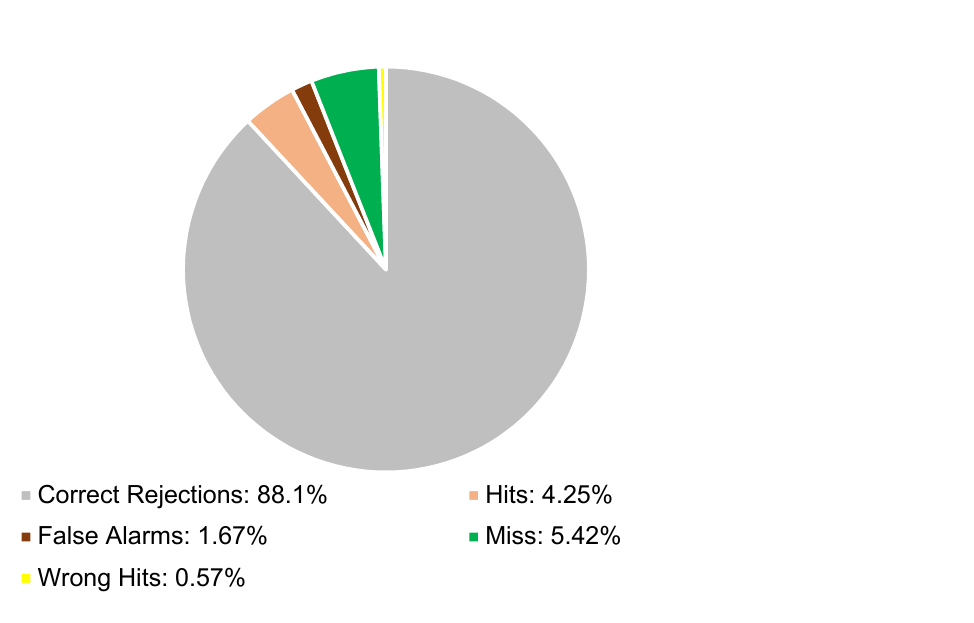
Table 7. Comparison between observed and simulated land use.